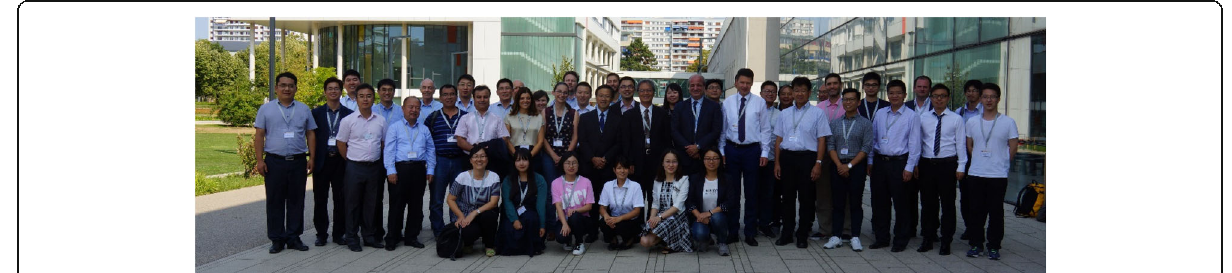
Fig. 3 Group photo of participants of the 16th ICGdR